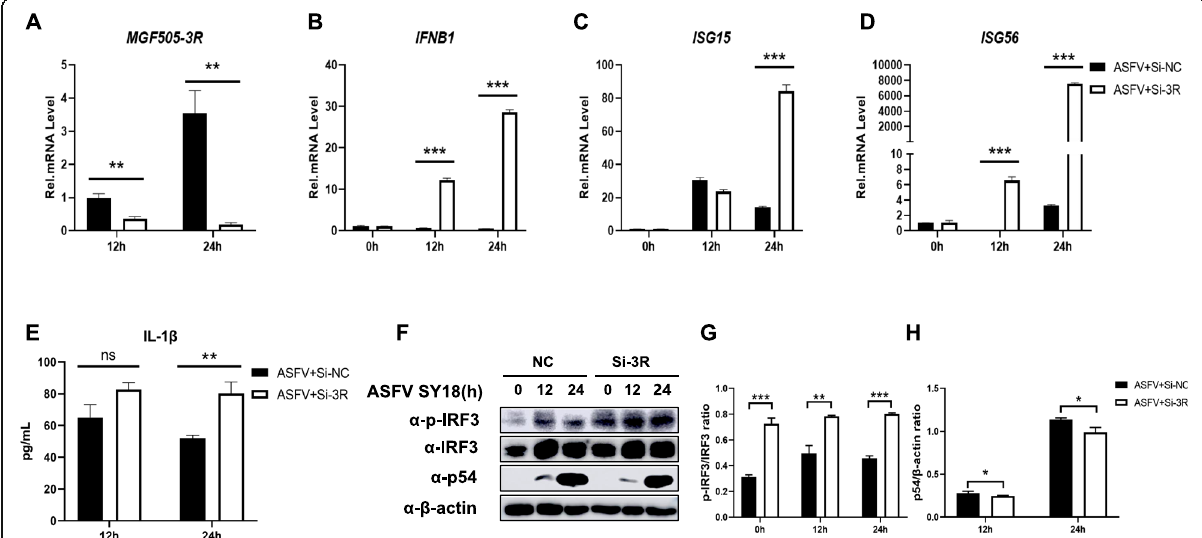
Fig. 6 MGF505-3R knockdown enhanced IFN- β and IL-1 β production. PAMs were transfected with siMGF505-3R-259 or nontargeting control siRNA for 24 h followed by infection with ASFV (MOI=1) for 12 h or 24 h. Cells were collected at the indicated times. A-D Endogenous MGF505- 3R, ISG15, ISG56, and IFNB1 mRNA levels were assessed by qRT – PCR assay. E ELISA was used to assess secretion of the cytokine IL-1 β in the cell supernatant. F-H Western blotting was used to assess cellular or viral protein expression levels and quantitative analysis of protein blots using ImageJ software. “ + ” represents transfected, “ - ” represents nontransfected. All experiments were repeated independently at least thrice. All data from 3 independent experiments are expressed as the mean ± SD. *{ P <0.05}, **{ P <0.01}, ***{ P